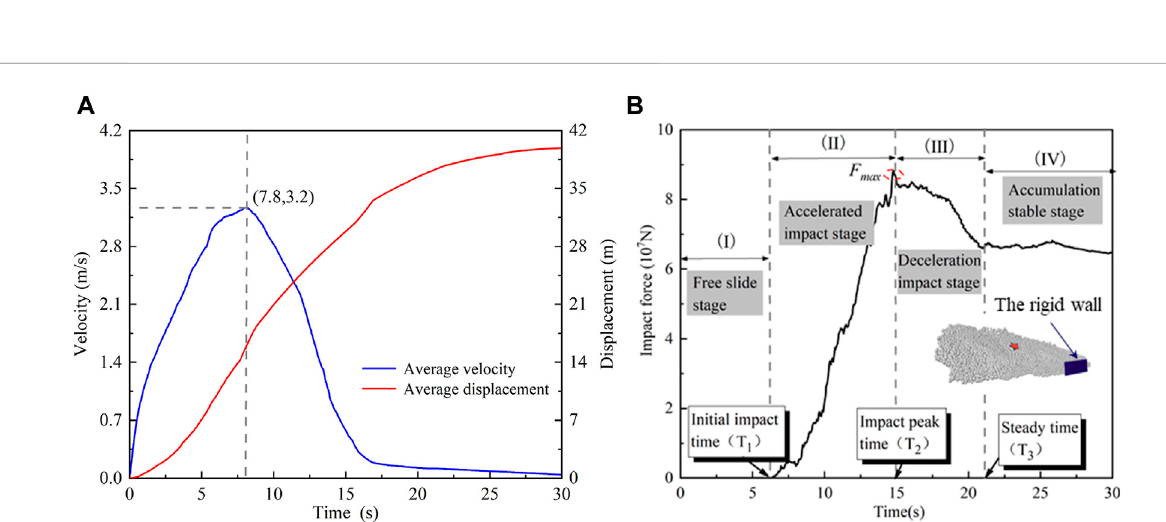
TABLE 3 Landslide velocity and displacement. Velocity (m/s) Displacement (m) Method Numerical method Scheidegger Numerical